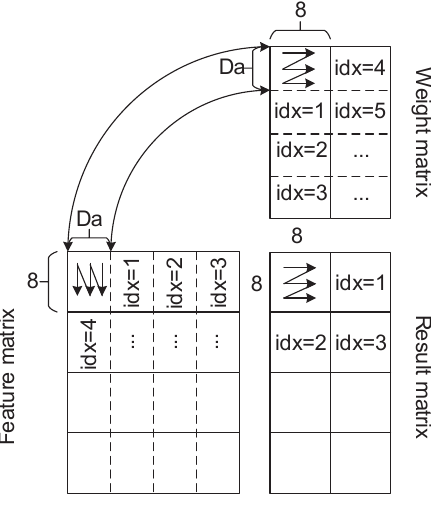
Figure 18. The computation process of matrix mode.